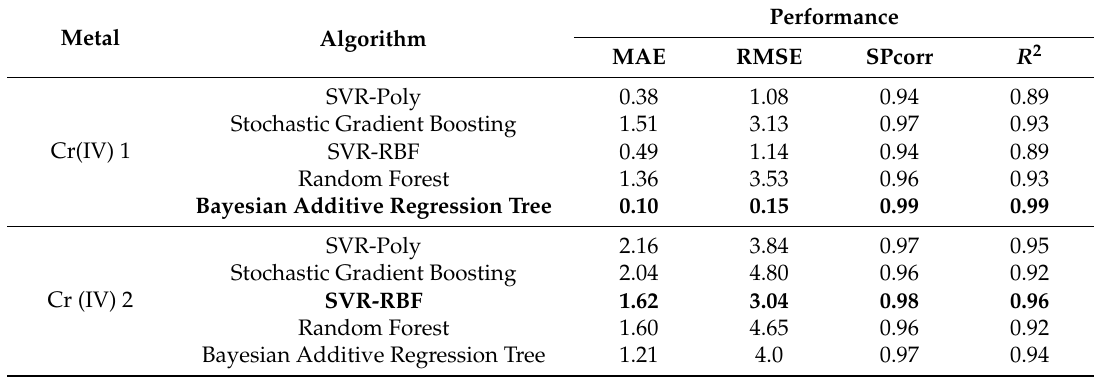
Table 7. The performances of five (5) MLA models on independent test data (20%) of Cd(II) datasets. Metal Algorithm